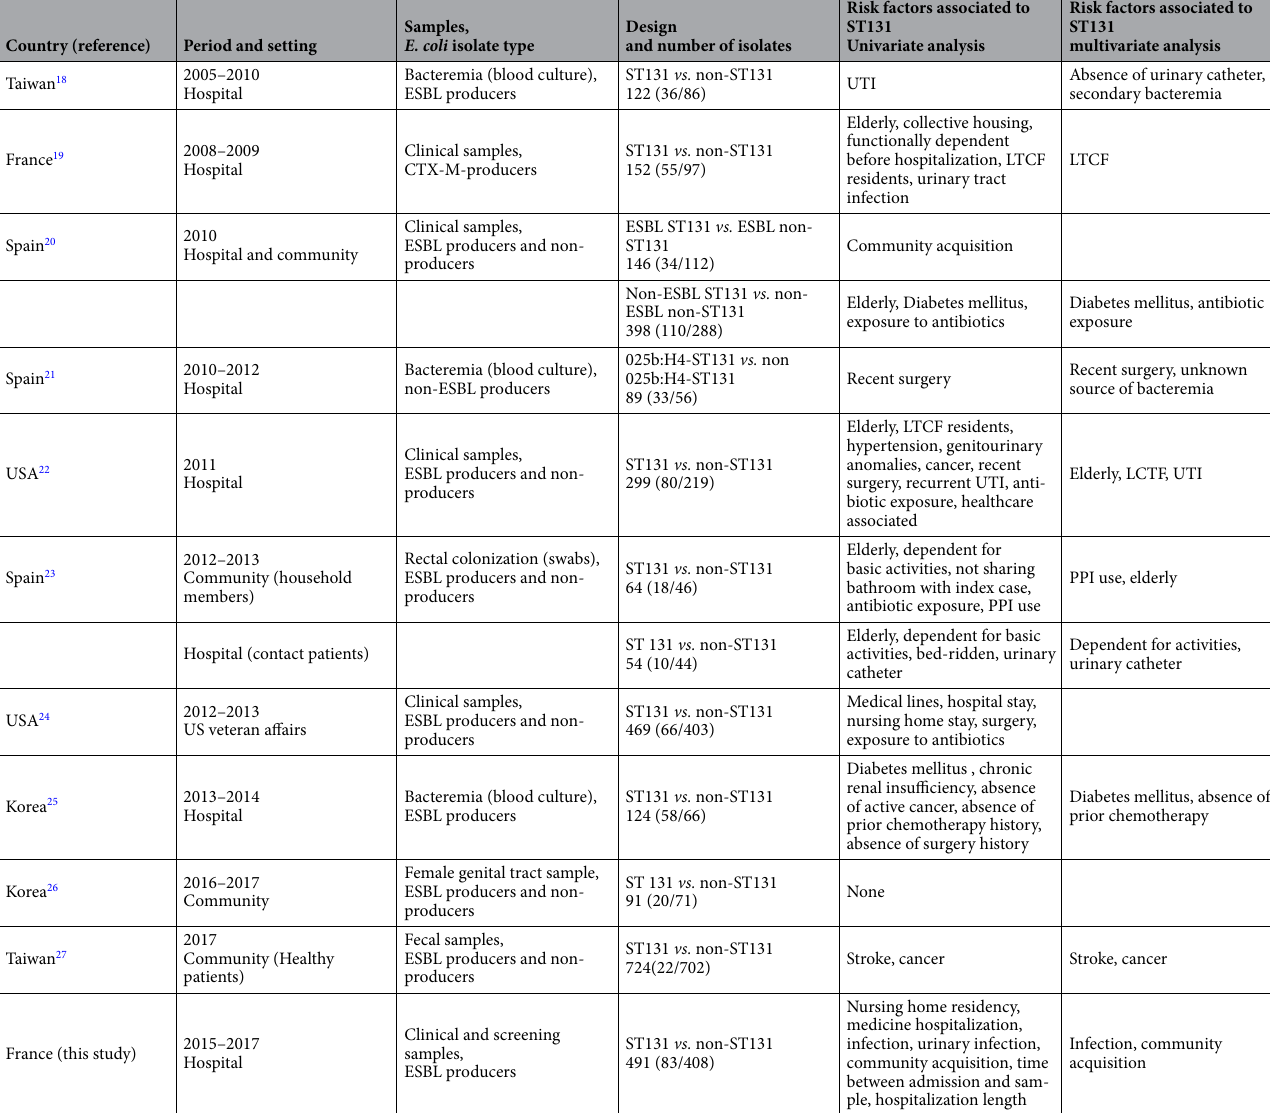
Table 2. Review of risk factors associated with Escherichia coli ST131 carriage. ESBL extended-spectrum- β - lactamase-producing; BSI bloodstream infection; UTI urinary tract infection; LTCF long-term care facility, PPI proton pump inhibitors.